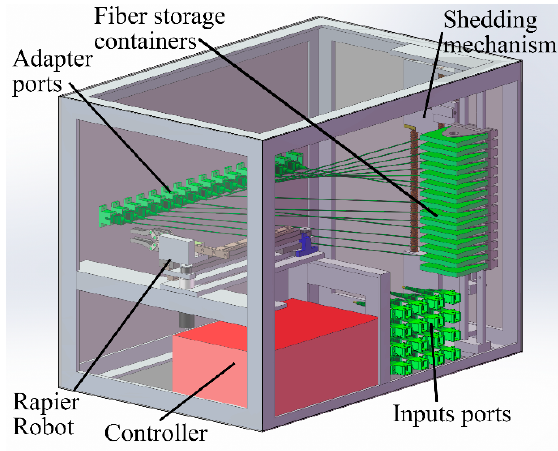
Figure 19. Drawing of the AODF prototype.